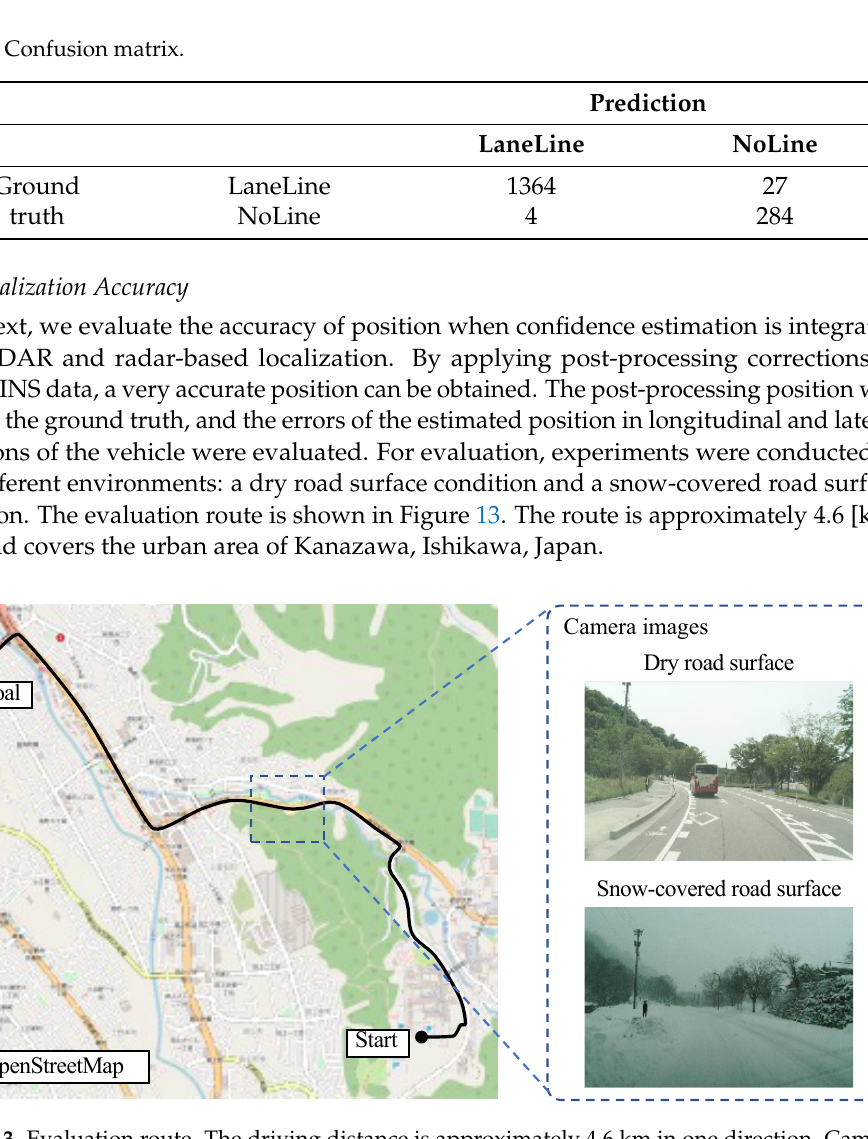
Figure 13. Evaluation route. The driving distance is approximately 4.6 km in one direction. Camera images are also shown as examples of actual road surface conditions under the two